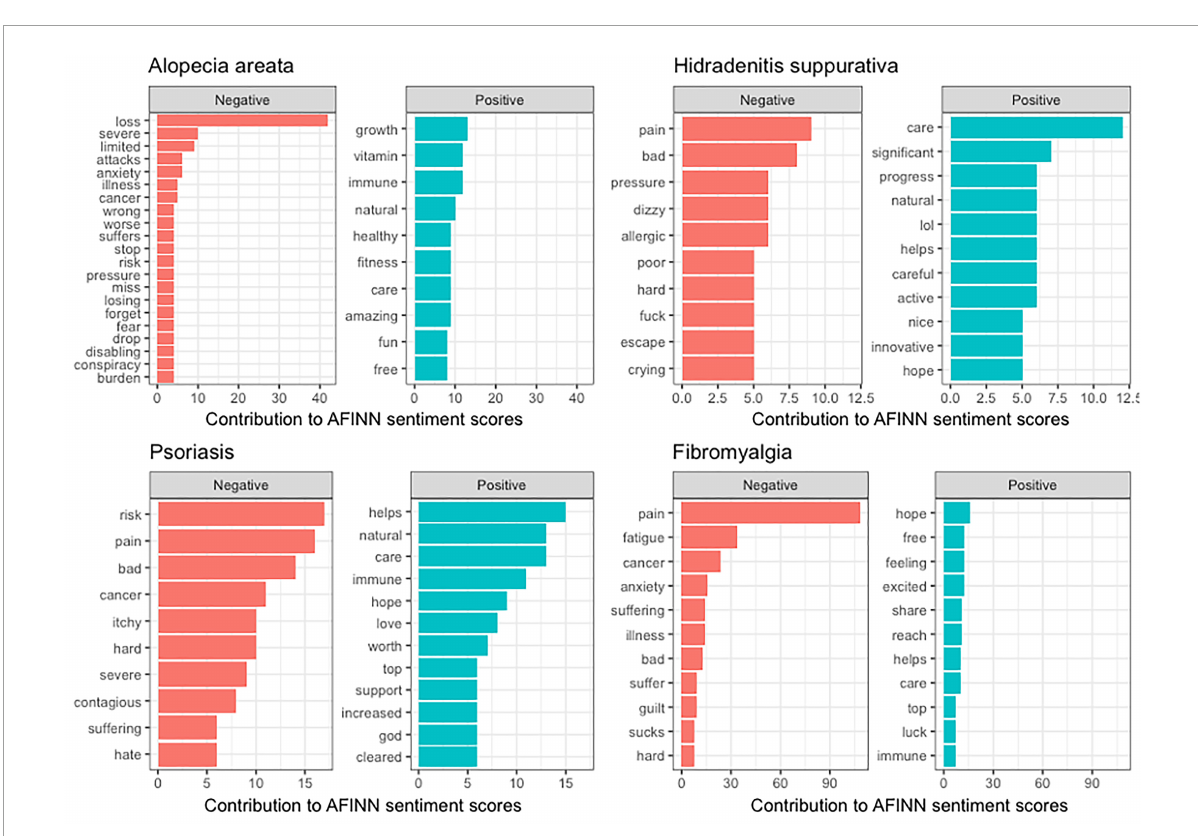
FIGURE1 AFINN sentiment scores of tweets on different diseases.